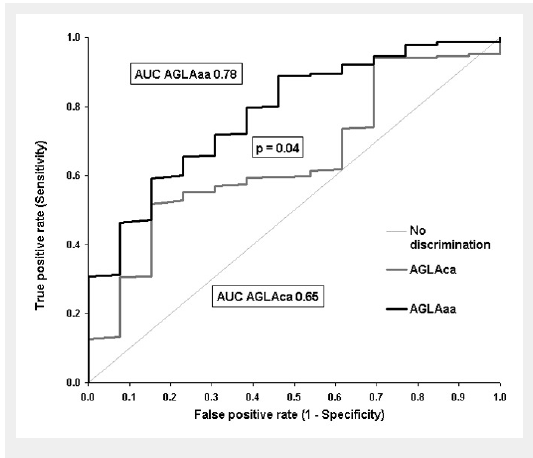
Figure 2 ROC Curve for AGLAca and AGLAaa for the detection of coronary events in the validation cohort [12]. Ability of AGLAca (black line, area = 0.65 (95% CI = 0.61–0.68, p = 0.041) and AGLAaa (grey line, area = 0.78, AGLAaa (95% CI = 0.75–0.81, p <0.0001) to detect 13 incident myocardial infarctions (p = 0.041). aa = arterial age; AGLA = Arbeitsgruppe Lipide und Atherosklerose (Swiss coronary risk calculator); AUC = area under the curve; ca = chronological age; CI = confidence interval; ROC = receiver operator characteristic